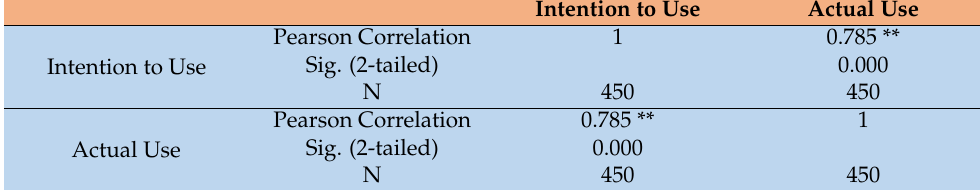
Table 15. Results of the correlation analysis for hypothesis 10 (H10).